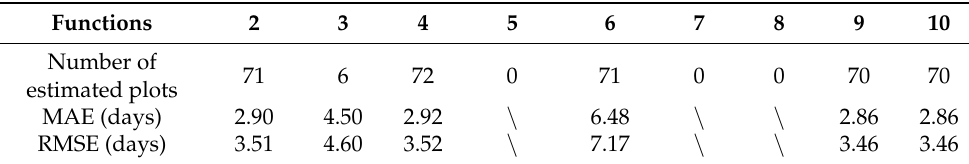
Figure 3. Plots affected by sample frame. ( a ) Orthomosaic, ( b ) side view, ( c ) dense point cloud of plot (sowing date: 5 October; variety: Xinong 529; density: 1.5 million plants/ha). Table 3. Estimated results of nine sigmoidal functions.